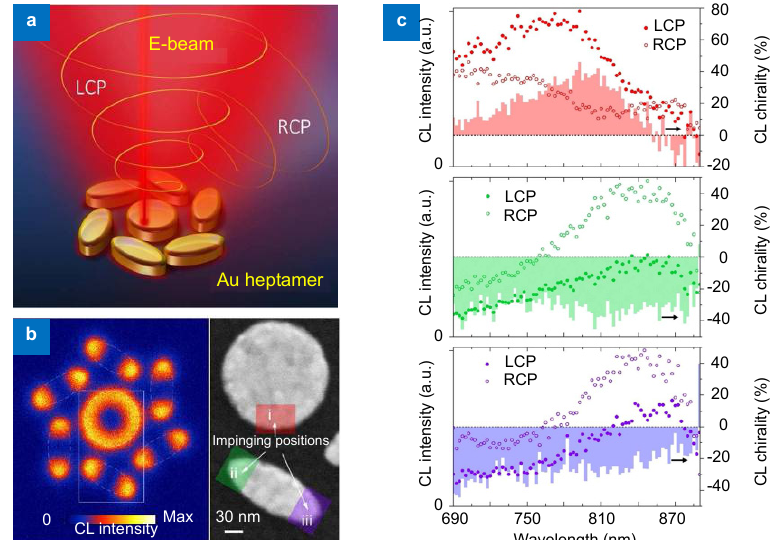
Fig. 8 | ( a ) Schematic of the electron stimulated heptamer nanostructure. ( b ) Left: panchromatic CL image of Au heptamer nanostructures. Right: part of SEM image of Au heptamer. ( c ) CL spectra measured from impinging positions as indicated in ( b ). Figure reproduced from ref. 72 , ACS Publications.